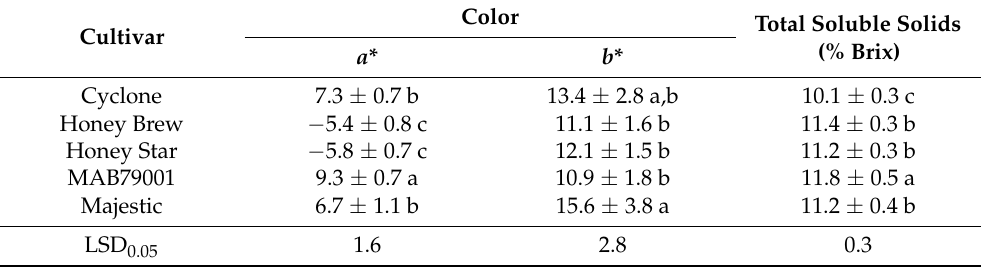
Table 4. Effect of cultivar on flesh color and total soluble solids of melon juice.